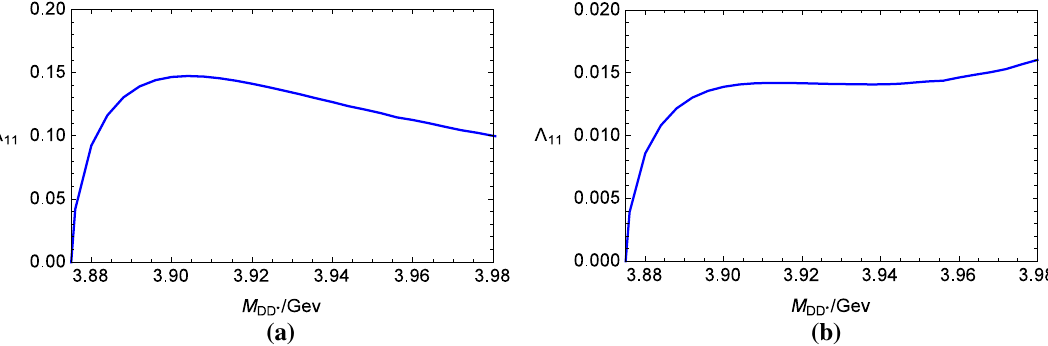
Fig. 8 Thecrosssectionofthe DD ∗ π channelamplitude(dividedby 32 πα | c 1 λ 1 h 1 h 2 | 2